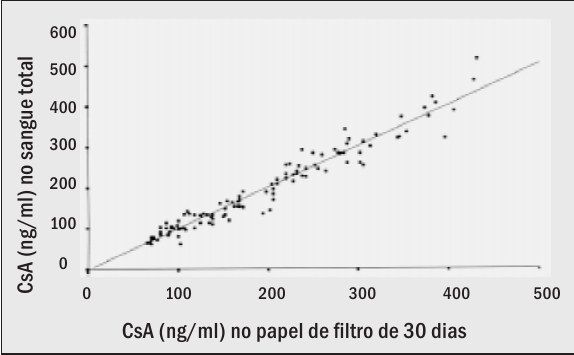
Figura 2 – Correlação linear entre as amostras de sangue total e amostras de papel de 30 dias ( r = 0,972; p < 0,0001)